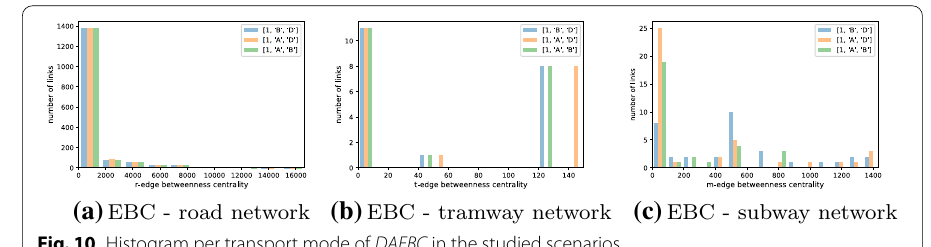
Fig. 10 Histogram per transport mode of DAEBC in the studied